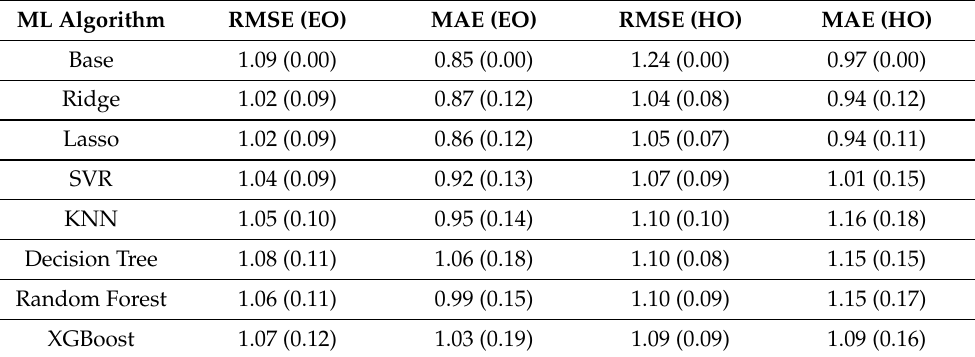
Table 5. EHO prediction results (regression problem) using I-F features. Nested cross-validation with 10 outer and five inner splits. EO (Eudaimonic orientation) and HO (Hedonic orientation). Numbers are the mean value of 10 outer splits. Numbers in parenthesis indicate the standard deviation values.